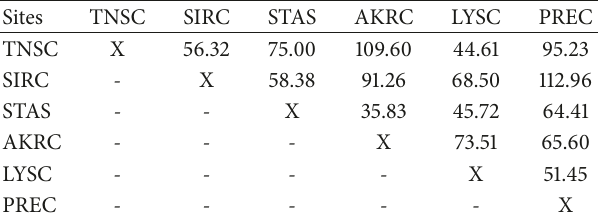
Table 2: Distances in subnetwork [Km].